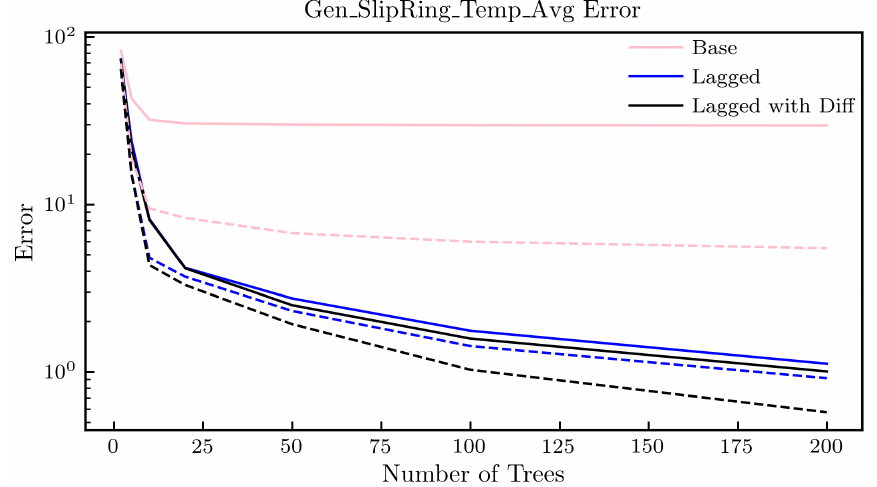
Figure 7. L-2 norm of the error of predicted generator slip ring temperature plotted as a function of trees in the random forest model (NBM-LI). The solid lines show the results associated with only using the generator speed and power produced. The dashed lines show the results associated with all SCADA signals, excluding the generator slip ring temperature. The different colors represent results associated with the baseline data set (without feature engineering), lagging the data set, and examining the ratio of current to previous signal values in addition to lagging the